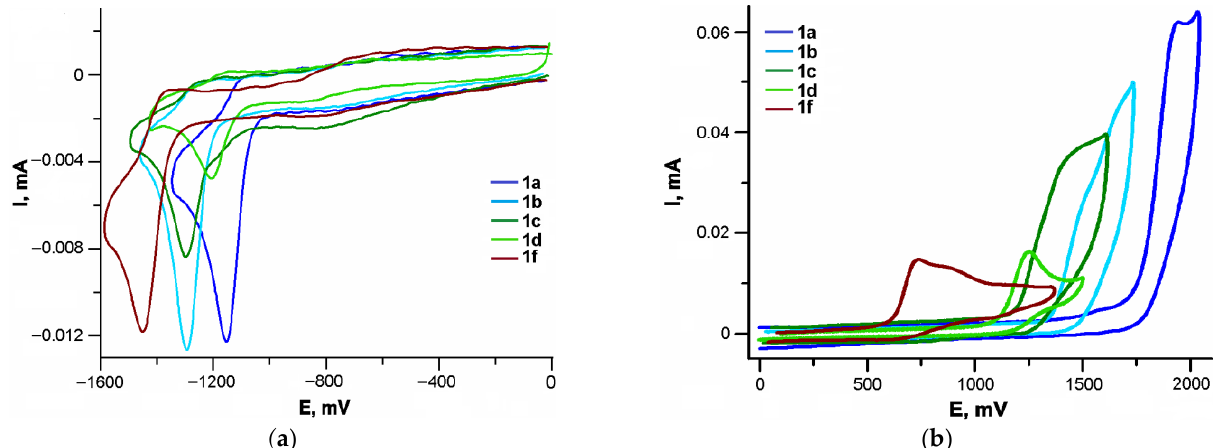
Figure 8. Voltammetric curves for the reduction ( a ) and oxidation ( b ) of dienones: 1a - d , f . The cathodic peak potentials of dibenzylidene cyclobutanones shift to the anodic region relative to the potentials of similar cyclopentanone derivatives and, to a larger extent, relative to cyclohexanone derivatives (Table 3 [34,35]). This may be due to the more planar molecular geometry of the dibenzylidene cyclobutanone derivatives, resulting in a higher degree of conjugation in comparison with similar cyclopentanone and cyclohexanone derivatives.